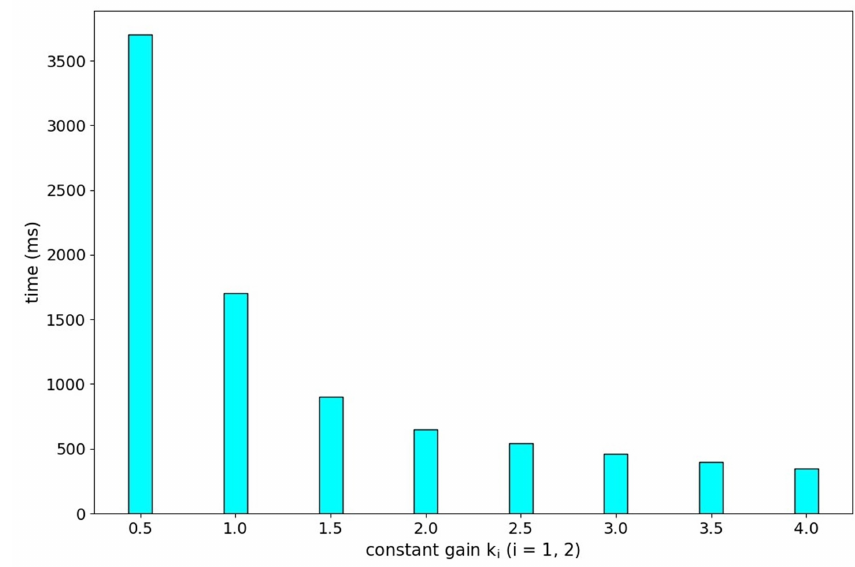
Figure 15. The time it takes for eye gazing affected by k 1 and k 2